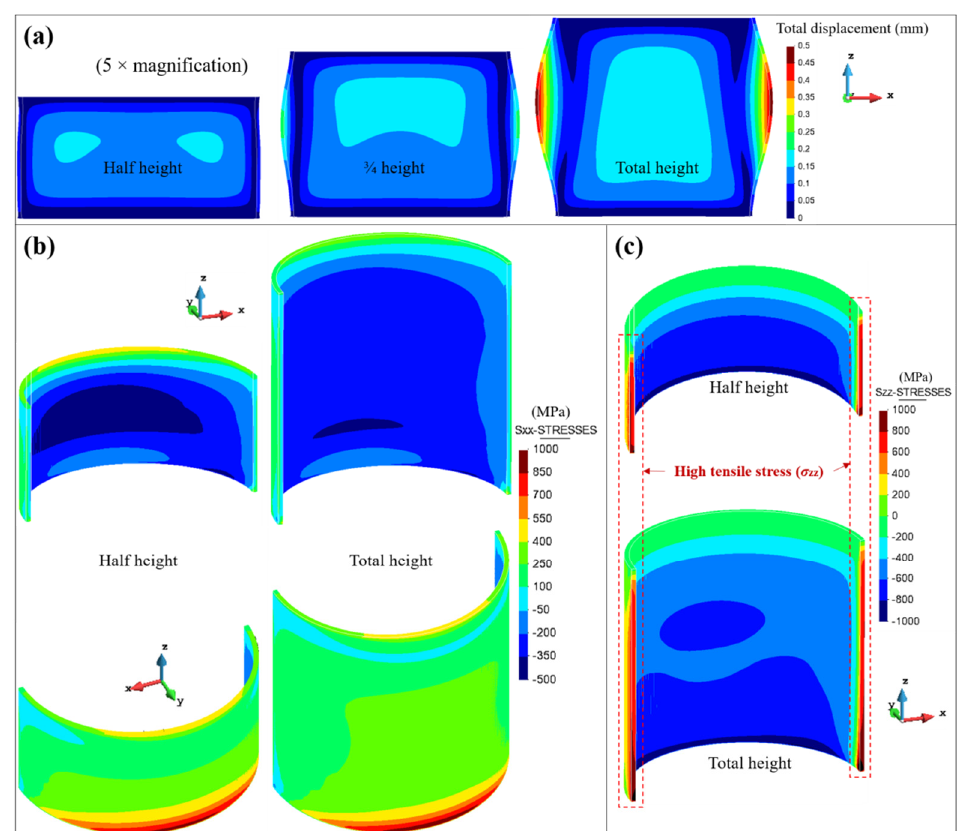
Figure 12. Semi-cylindrical part: the evolutions of ( a ) total displacements and ( b ) longitudinal stresses ( σ xx ) as well as ( c ) vertical stresses ( σ zz ).